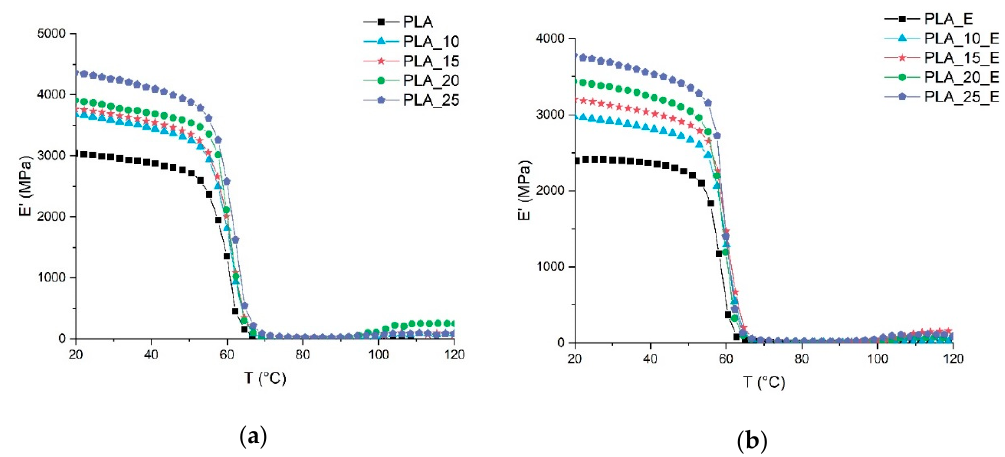
Figure 3. Storage modulus of PLA-Arbocel biocomposites as a function of temperature: ( a ) composite system without Einar, ( b ) composite system with Einar.